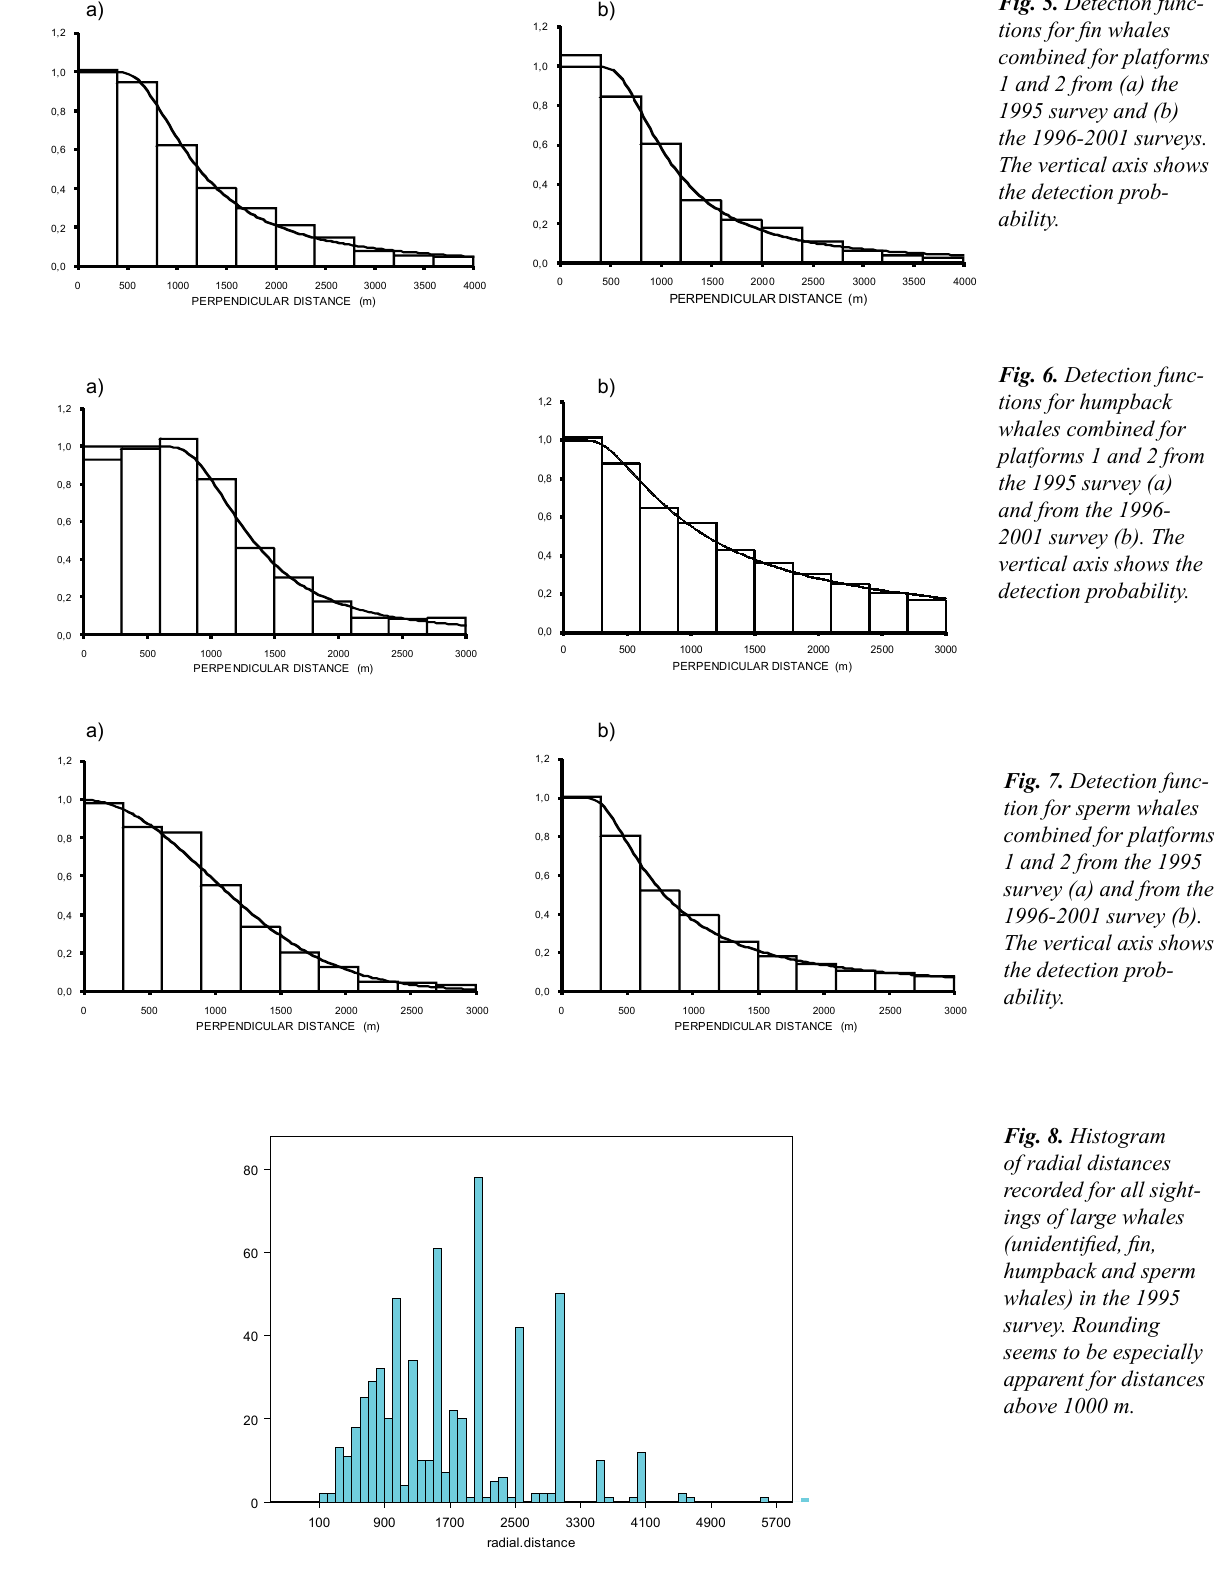
Fig. 5. Detection func- tions for fin whales combined for platforms 1 and 2 from (a) the 1995 survey and (b) the 1996-2001 surveys. The vertical axis shows the detection prob - ability.